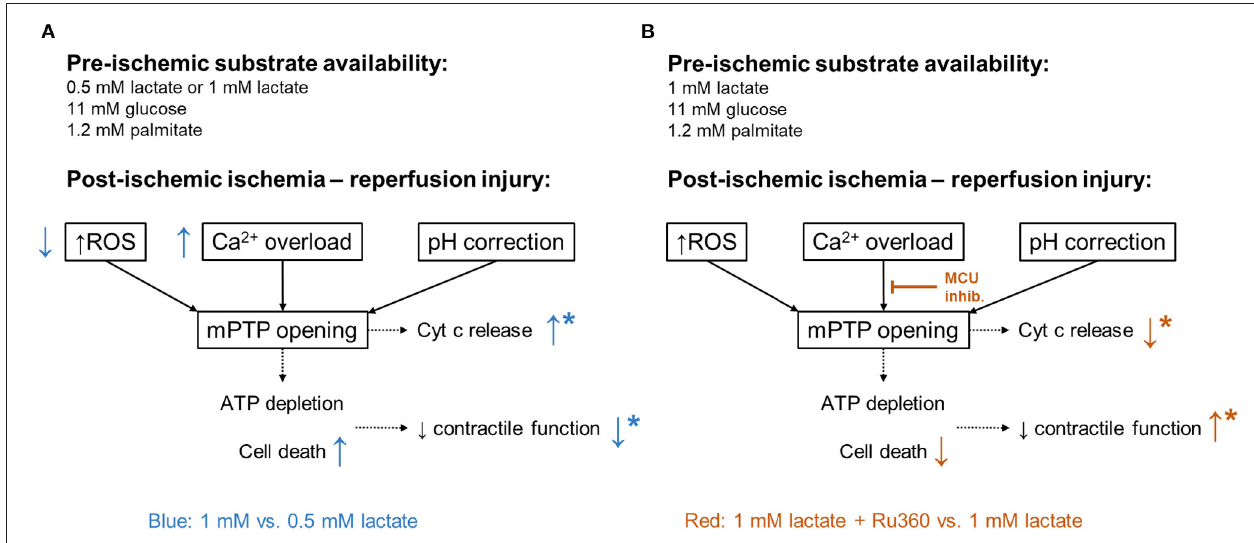
FIGURE 7 | Mediators of ischemia-reperfusion injury. In black: major mediators of lethal reperfusion injury: reactive oxygen species (ROS), calcium (Ca 2 + ) overload, and rapid pH correction contributing to the opening of the mitochondrial permeability transition pore (mPTP). ATP, adenosine triphosphate; Cyt c, cytochrome c. (A) In blue: differences observed in 1 Lac hearts compared to 0.5 Lac hearts. (B) In red: differences observed in 1 Lac + Ru360 hearts compared to 1 Lac hearts. *Indicates statistically significant difference; p < 0.05.